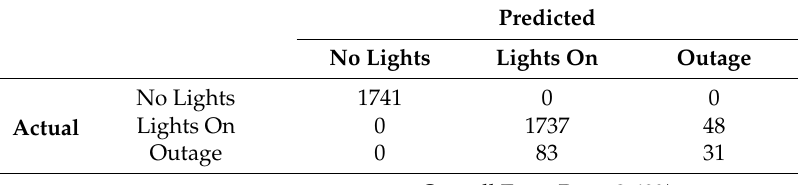
Table 1. Confusion matrix for out-of-sample testing data, actual and predicted outages.